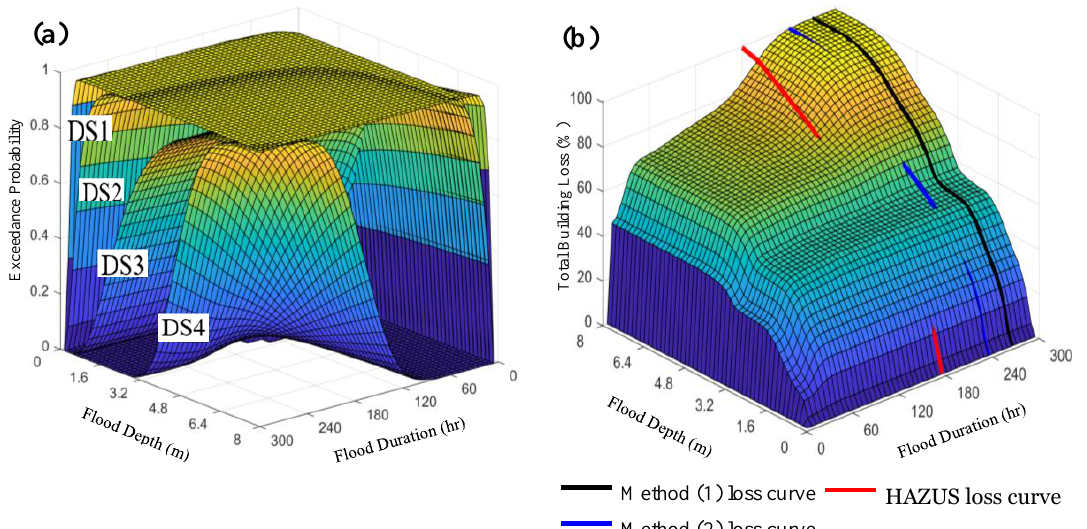
Figure 7. 3D building results for the F10 one-story school building archetype: ( a ) Fragility surfaces; ( b ) Loss surface.